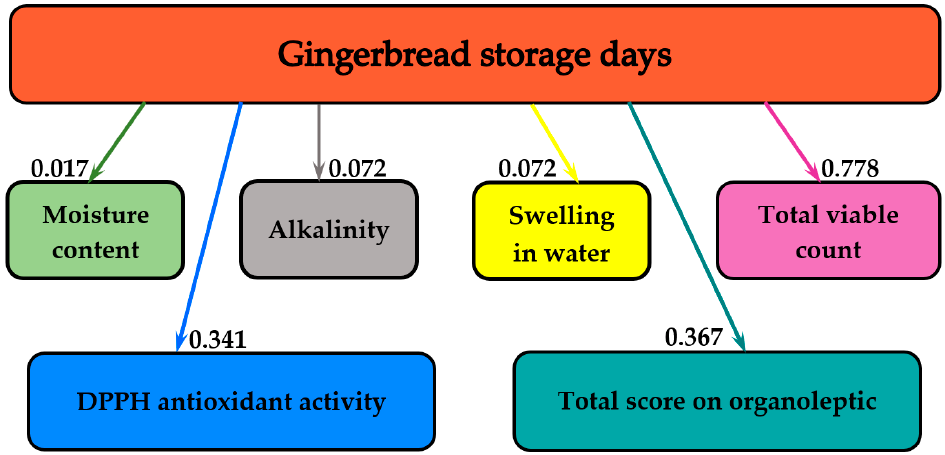
Figure 6. The informational analysis for the influence of storage days on gingerbread physicochemical and organoleptic parameters, DPPH antioxidant activity and total viable count.